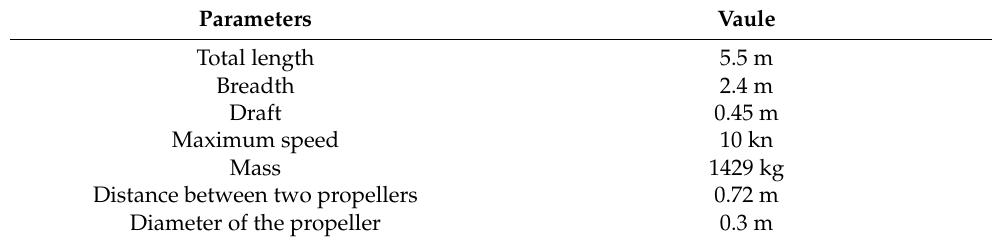
Table 3. Parameters of the “M80” USV.